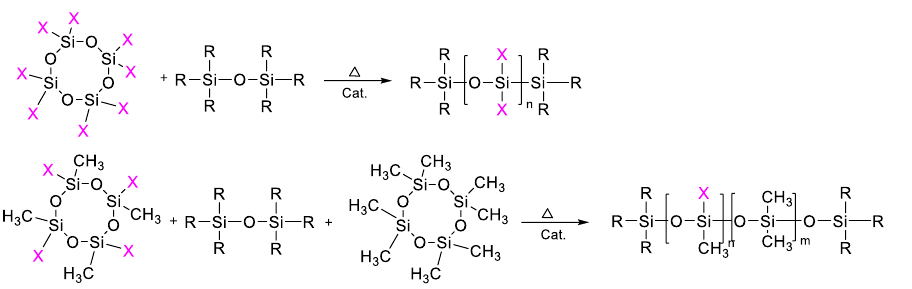
Figure 9. Obtaining functional PDMS by the ROP mechanism.